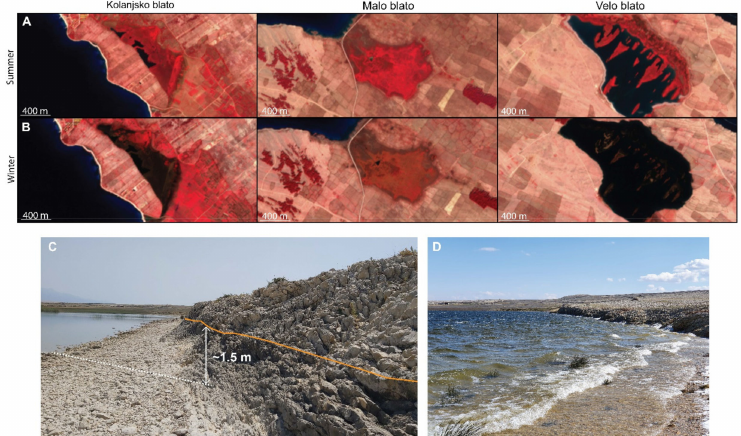
Figure 3. Satellite images (false-color composite Sentinel-2) of Kolanjsko, Malo, and Velo Blato during the dry ( A ) and wet ( B ) seasons in 2021 [84]; photos of the Lake Velo Blato surface level during the dry (June 2021; ( C )) and wet (March 2021; ( D )) periods—the lake level was up to 1.5-m lower during dry